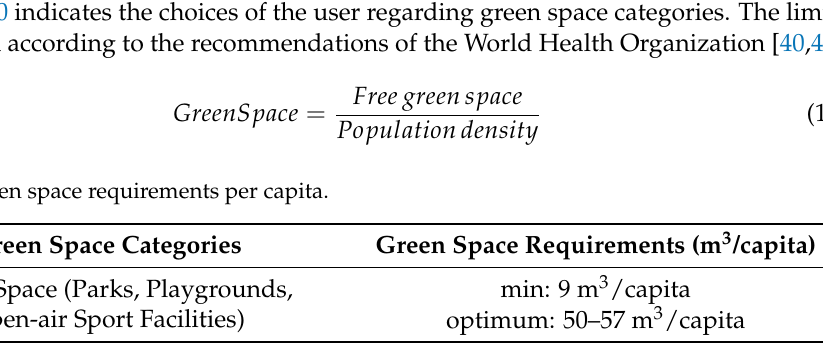
Table 10 indicates the choices of the user regarding green space categories. The limits were chosen according to the recommendations of the World Health Organization [40,41].